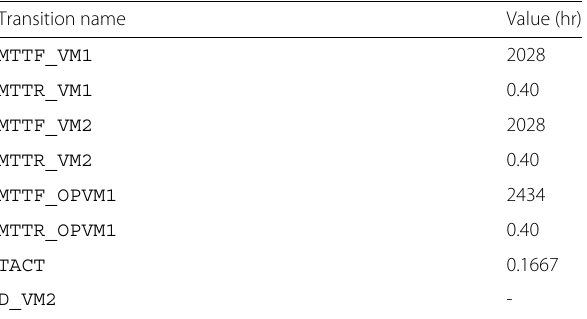
Table 7 Planning for design of experiments of the first